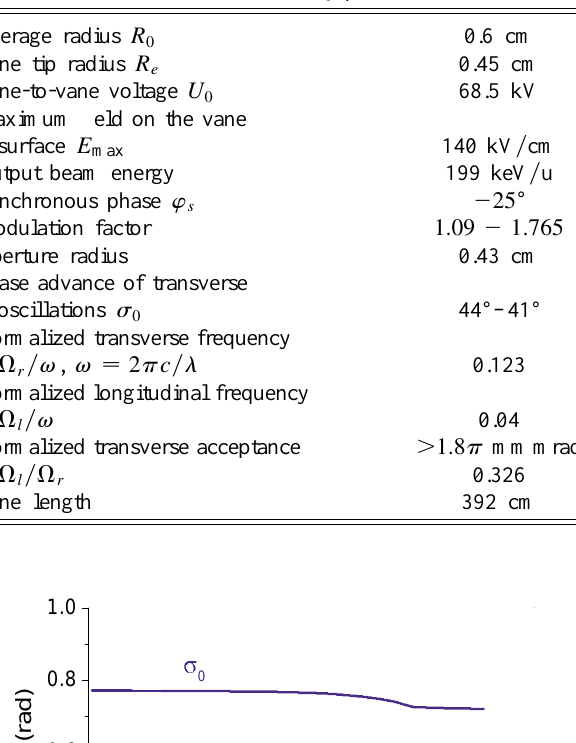
TABLE II. Main RFQ parameters.